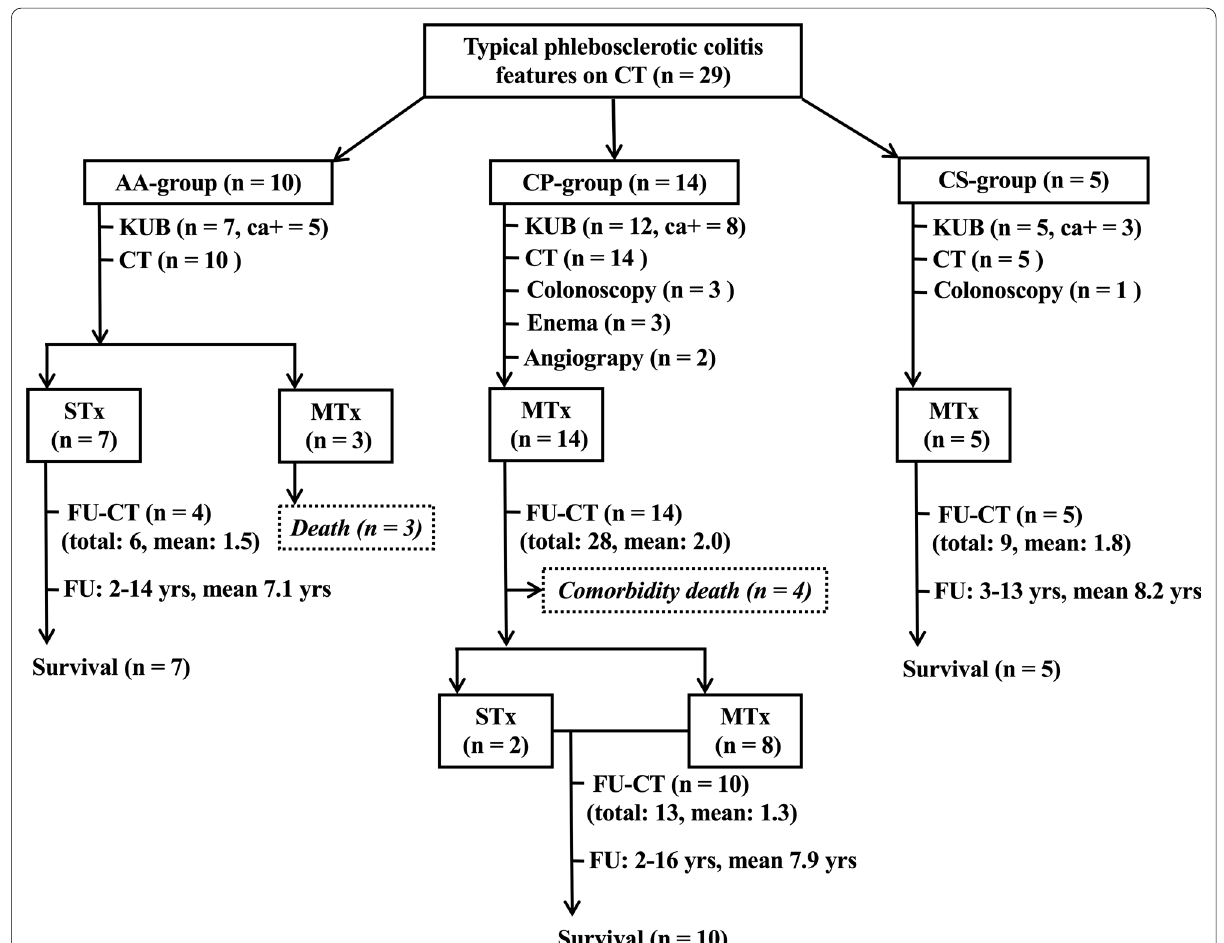
Fig. 1 Selected treatment, radiological examinations, colonoscopy and outcomes in three groups of patients with PC. ca ( calcifications positive; STx, surgical treatment; MTx, medical treatment; FU, follow‑up; total, total number of CT